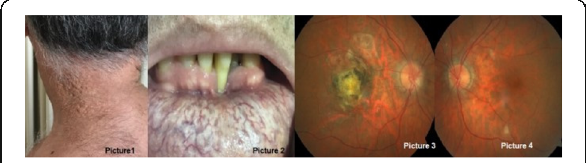
Fig. 1 (abstract P358). Picture 1, Picture 2 Picture 3 (Presence of angioid streaks with disciform scar and uncompromised vessels) Picture 4 [Presence of angioid streaks with vascular narrowing and cotton wool spots in upper and lower temporal vessels